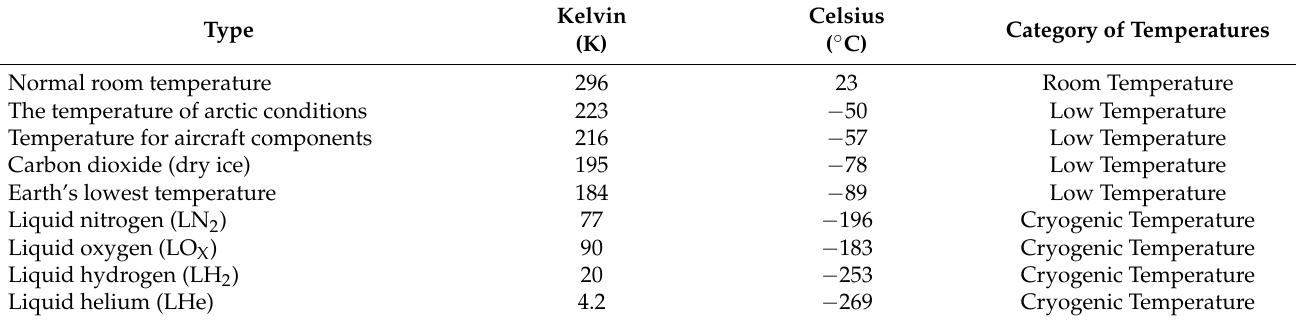
Table 6. Different levels of cryogenic temperatures used in the polymer–matrix composites adapted from reference